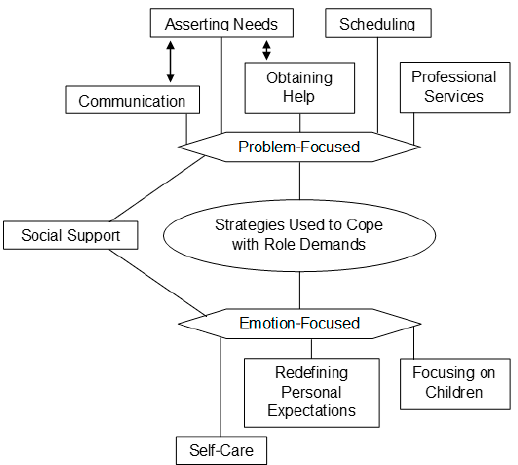
Figure 4. Visual map of Theme 3 by codes. Note. A line indicates that one component is a factor of another, and two arrows indicate a bidirectional in fl uence.